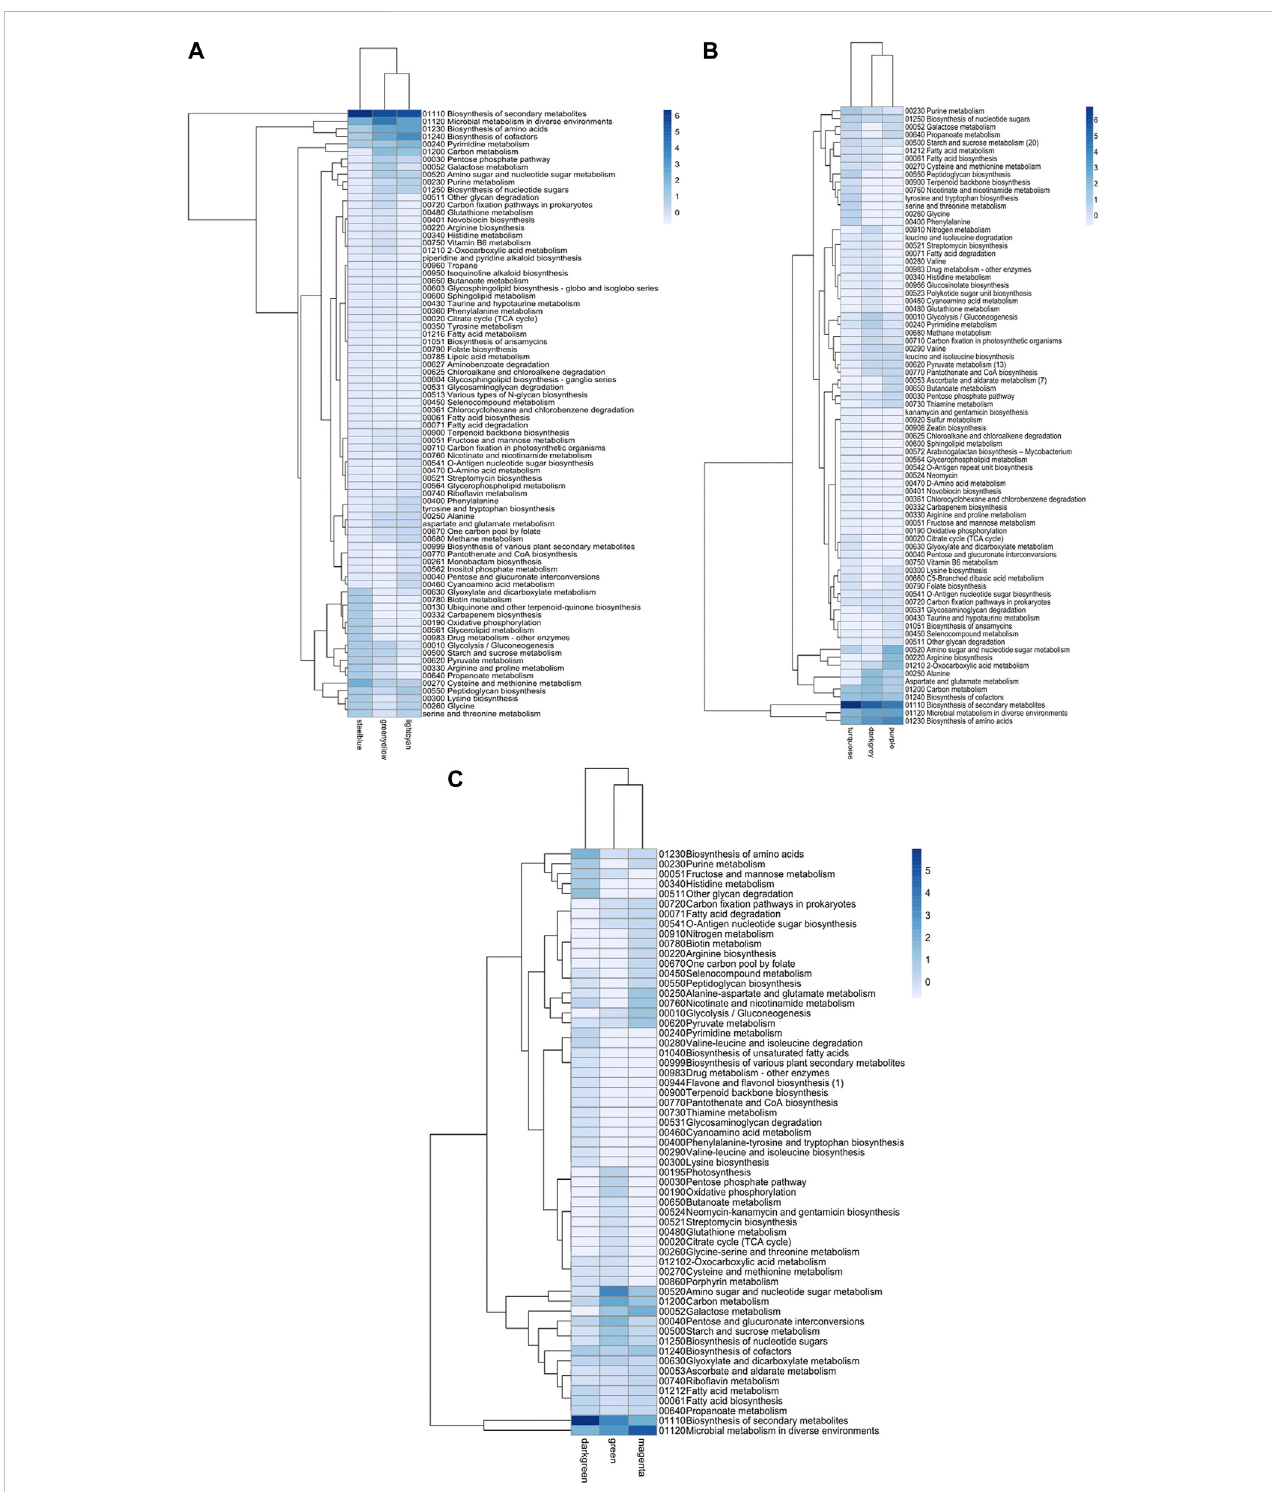
FIGURE 6 Metabolic map abundance in Bi fi dobacterium species. (A) B. infantis ATCC 15697, (B) B. bi fi dum SC555, (C) B. longum subsp. longum SC596. Each row represents a metabolic map (KEGG), and each column represents the most enriched